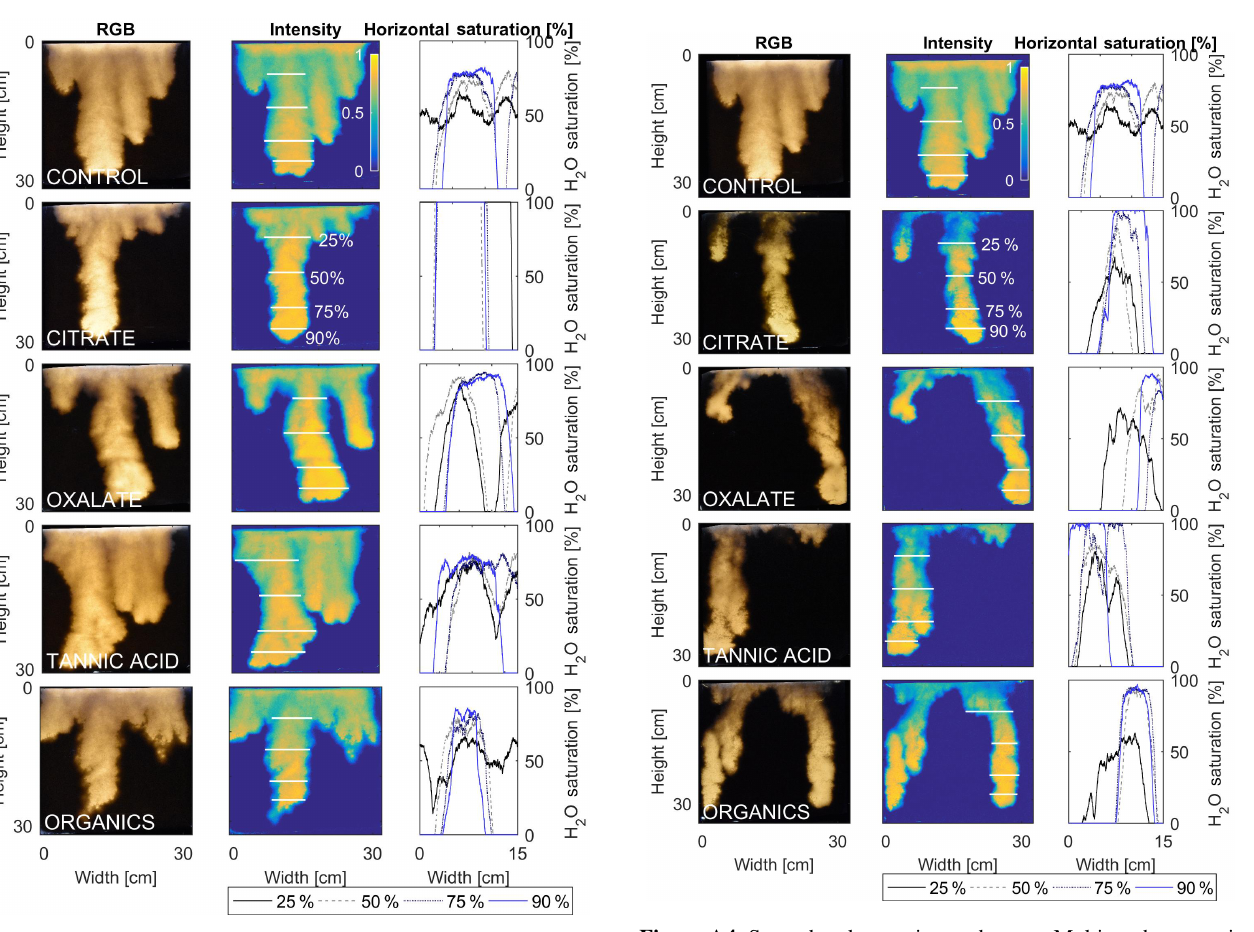
Figure A3. Second tank experiment data set. Multigraph compari- son of the finger width profiles of infiltration of water in US Silica C778 ASTM graded sand for control (NaCl + HNS), and low con- centrations of plant exudates (citrate and oxalate) and soil compo- nents (tannic acid and organics: Suwanee River natural organic mat- ter, SRNOM). The images are of the main finger at its full length. The location of the horizontal water saturation profile analyses and widths are measured at 25, 50, 75, and 90% of the total fingers length.